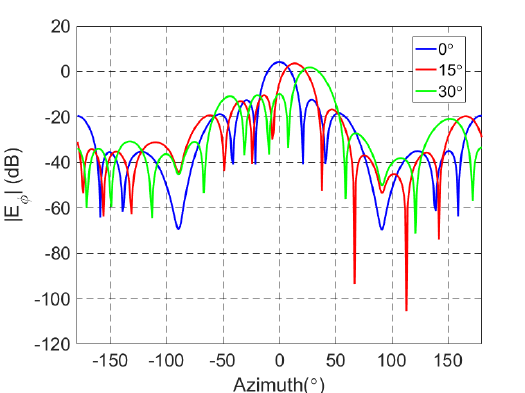
Figure 10. Azimuth plane radiation pattern of the NULA with five Televes 4G NOVA antennas without the radome or reflector, for 770 MHz, and optimized distances, with three steering directions: 0 ◦ (broadside), 15 ◦ and 30 ◦